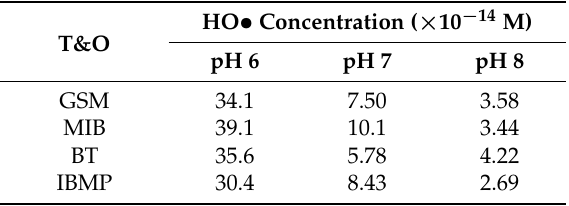
Table 2. Steady-state concentration of HO • in the UV/chlorine advanced oxidation processes (AOPs). Condition: pH = 6; chlorine dosage = 50 µ M; GSM and MIB dosage = 400 nM; BT and IBMP dosage = 1 µ